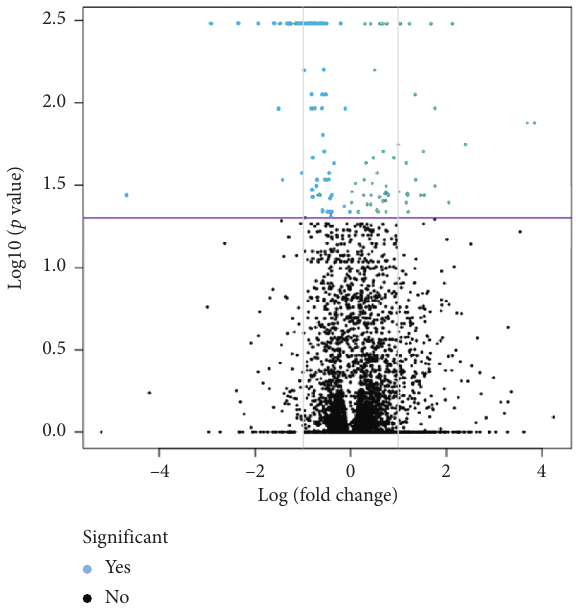
Figure 2: Volcano plot highlighting the genes differentially expressed between the group exposed to benzo(a)pyrene and the control group. A total of 156 differentially expressed genes ( p < 0 . 05) were detected. In blue, we show the genes that presented statistically significant difference comparing the expression be- tween both